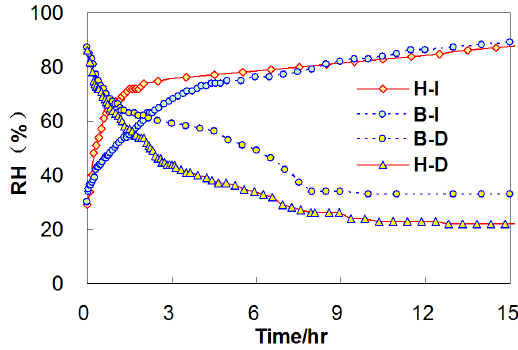
Figure 12. The dehumidifying and humidity increasing properties of the PoSt-g-BMD-C (H-I: Humidity increasing with moist coatings, B-I: Blank humidity increase, H-D: Humidity decreasing with dry coatings; B-D: Blank without coatings).